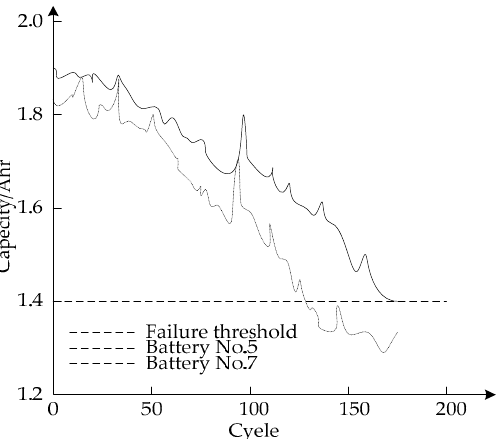
Figure 5. The capacity degradation trajectories of No.5 lithium battery and No.7 lithium battery.